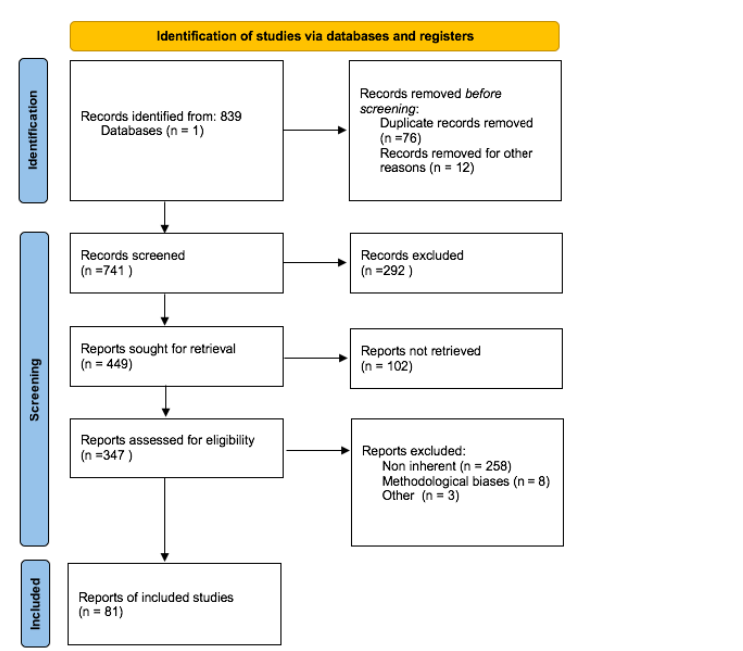
Figure 2. PRISMA flow diagram with a detailed report of the literature revision.